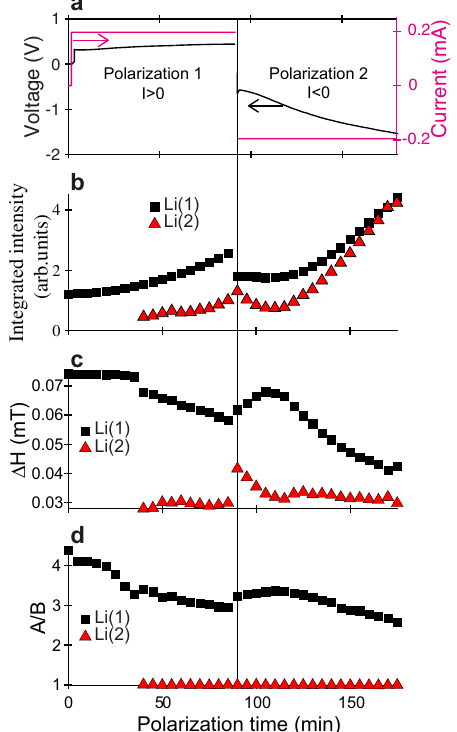
Fig. 2 Evolution of the cw-EPR parameters versus polarization time for the two components, Li(1) (bulk Li) and Li(2) (micrometric particles). a Voltage (left) and current (right) of the electrochemical cell, b integrated intensity, c linewidth Δ H and d asymmetry ratio